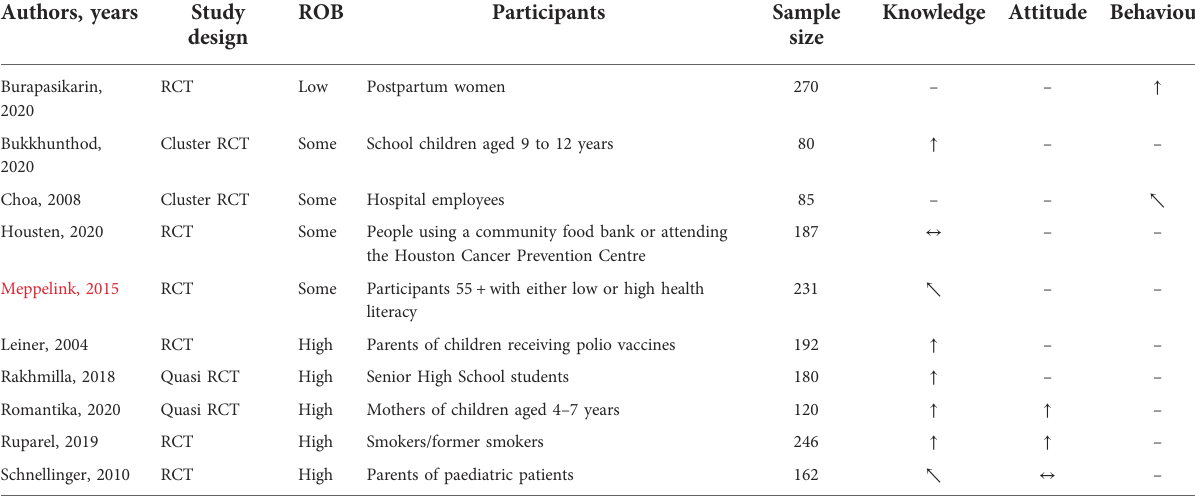
TABLE 3 Category 3 fi nding (topics related to public health, health promotion or illness prevention). Authors,